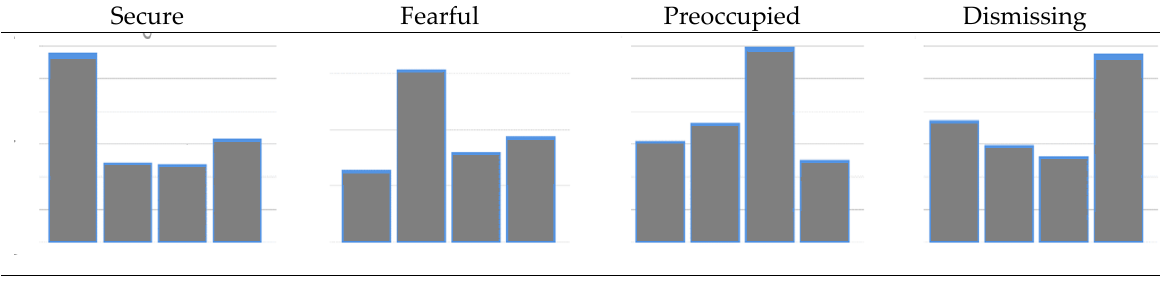
Figure 2. Discrepancy between RQ 2 scores in each attachment style.